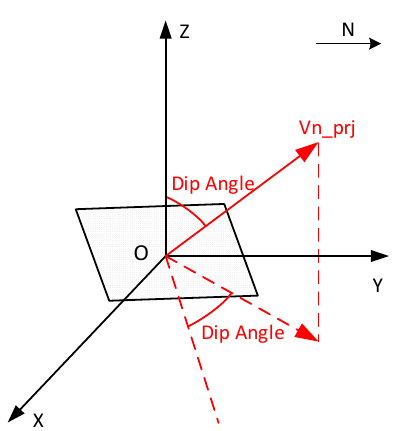
Figure 7. Schematic Diagram of Spatial Relation Between Sensors and the Shield Machine ( a ) and Expected Motion Stages of a Sensor Node Caused by Shield Tunneling ( b ) (modified from [11]).